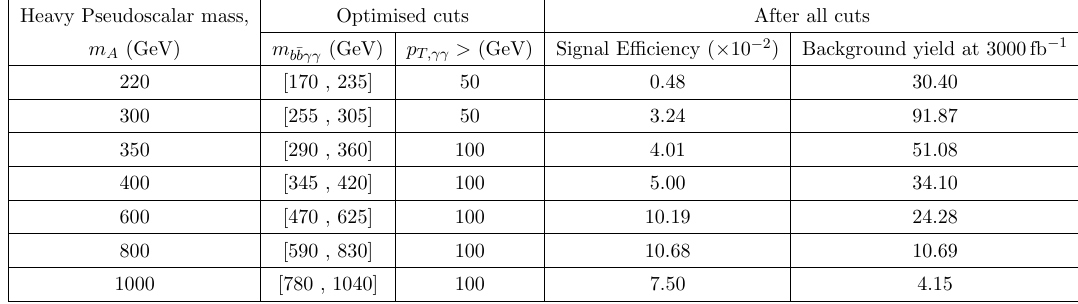
Table 6 . Details of the (cid:12)nal optimised cuts with signal e(cid:14)ciency and background yields after applying all cuts.